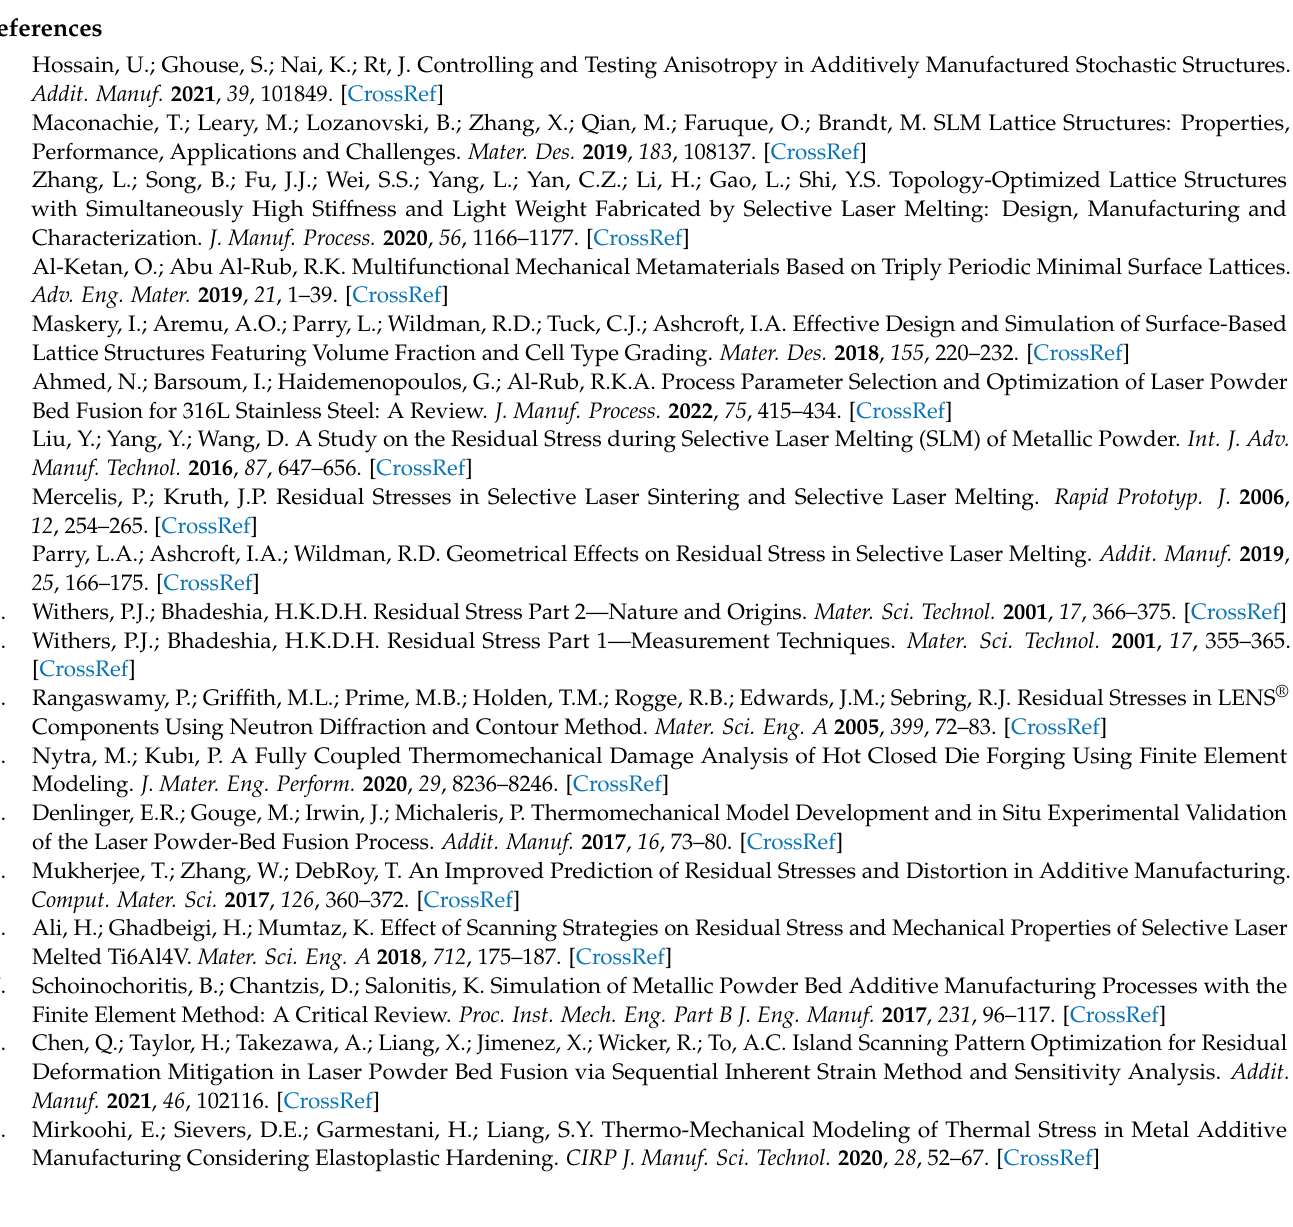
Figure A1. Sample used for comparison with current simulation study: ( a ) geometric dimension of the curve plate and stress measurement location (T1) indicated by red dotted line; ( b ) comparison of simulated residual stress component σ z with experimental measurements from literature